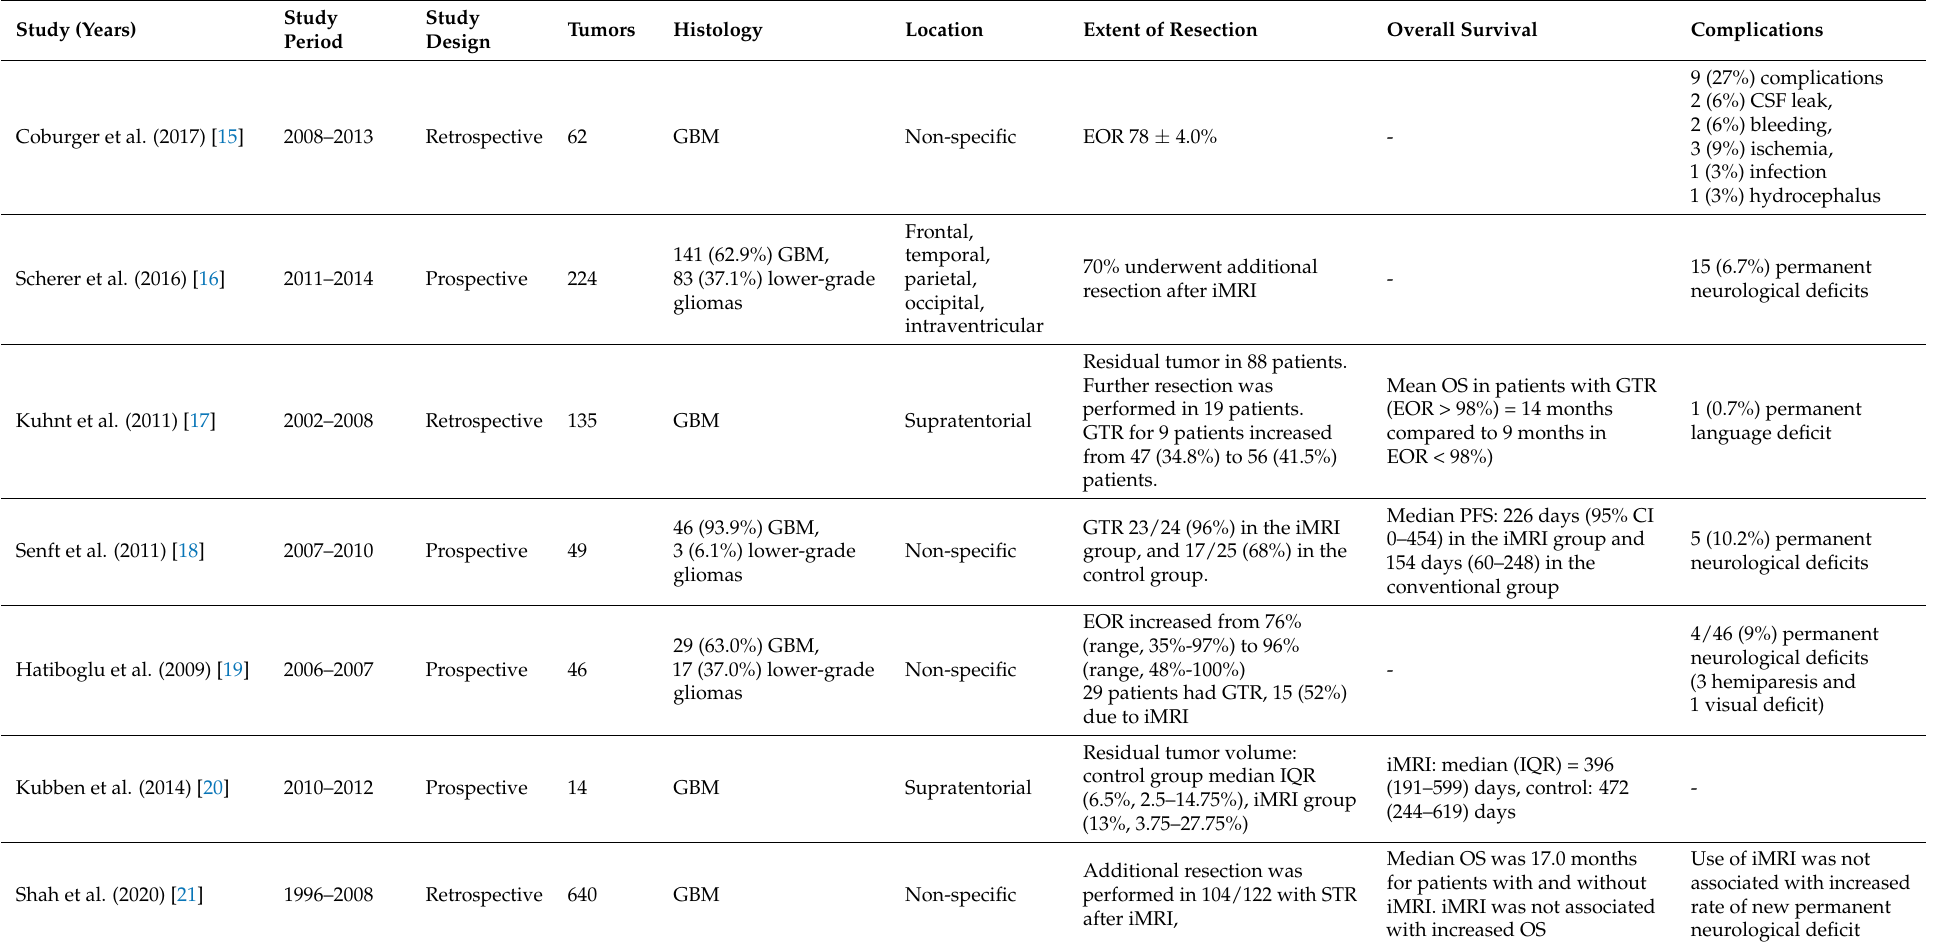
Table 1. Studies investigating the role of intraoperative MRI in improving the extent of